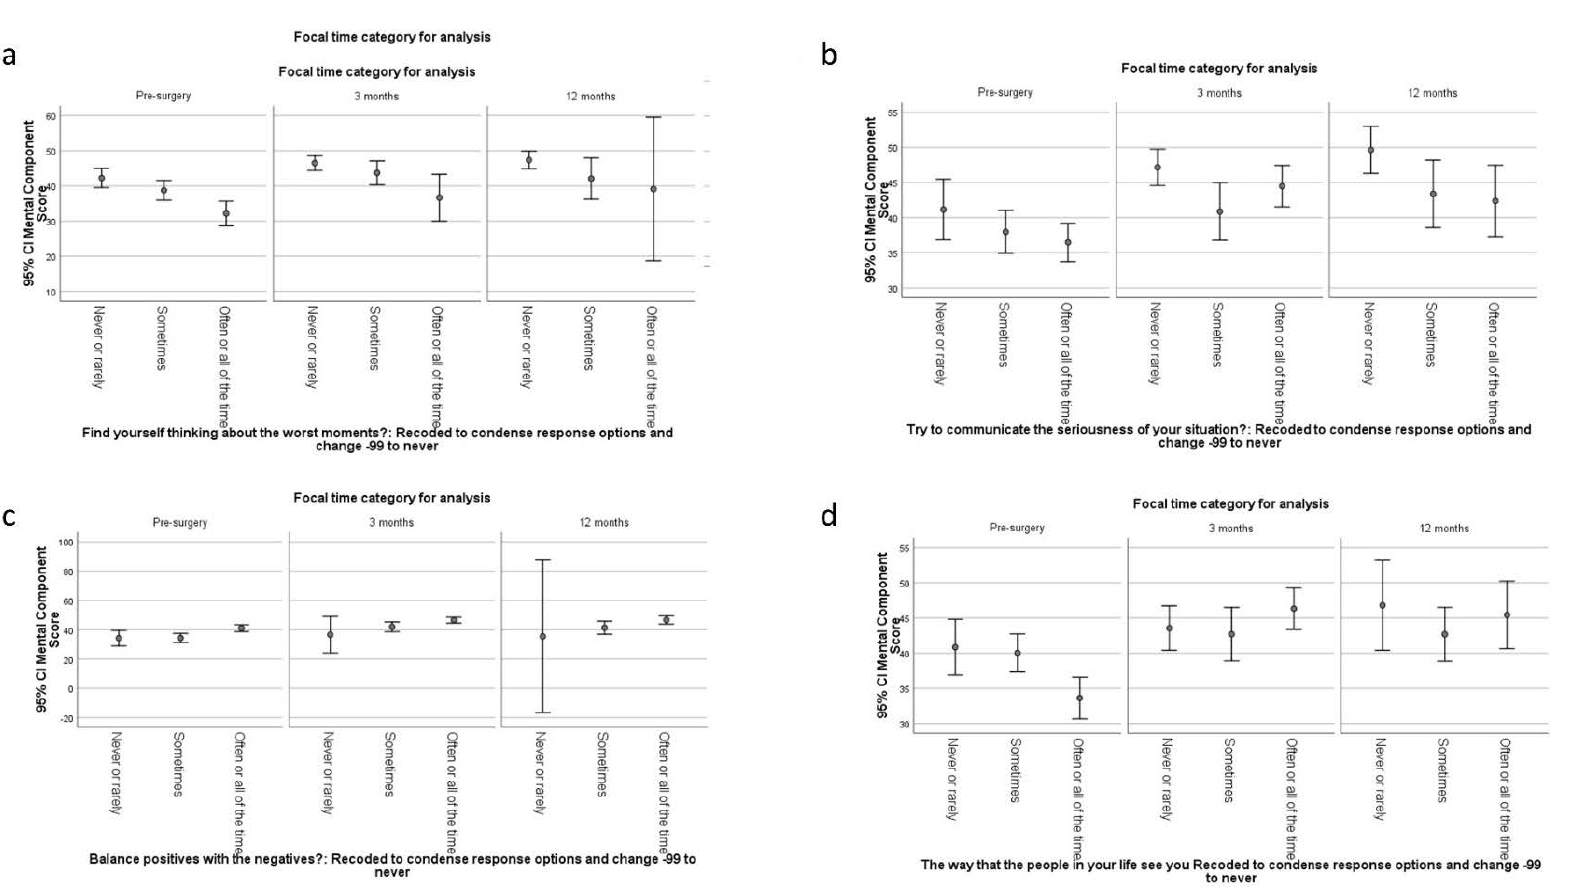
Figure 4. Relationship of Appraisal with MCS Over Time ( a – d ).